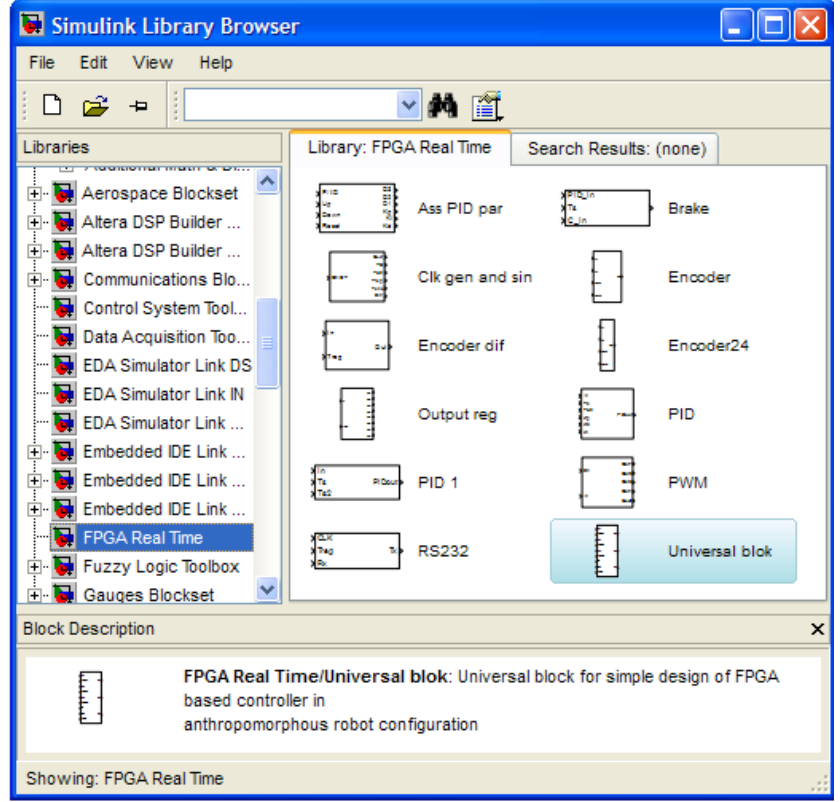
Figure 6. Robotics Real Time Toolbox in the Matlab environment.